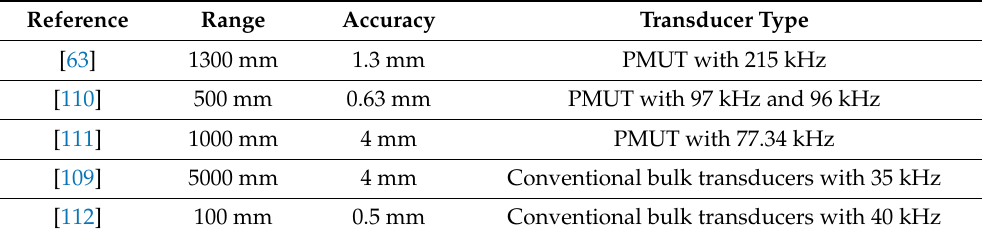
Table 2. Performance comparison of several ATM-based ranging systems.